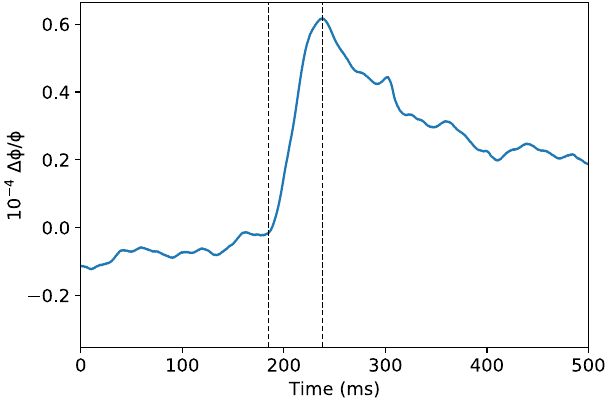
FIG. 1. Strongest flux jump observed during the measurement of relative magnetic flux error in an 11 T dipole model. The dashed lines limit the fast rise up time of the flux jump.